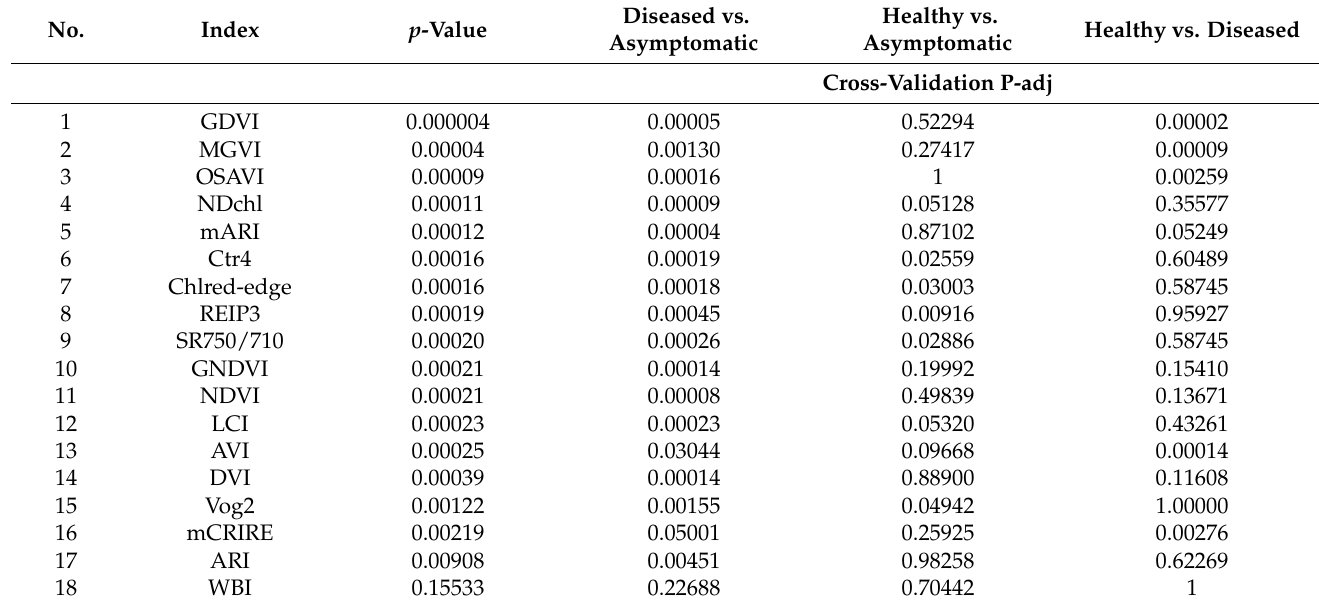
Table A1. Non-parametric ANOVA and its relative cross-validation results for the VIs.